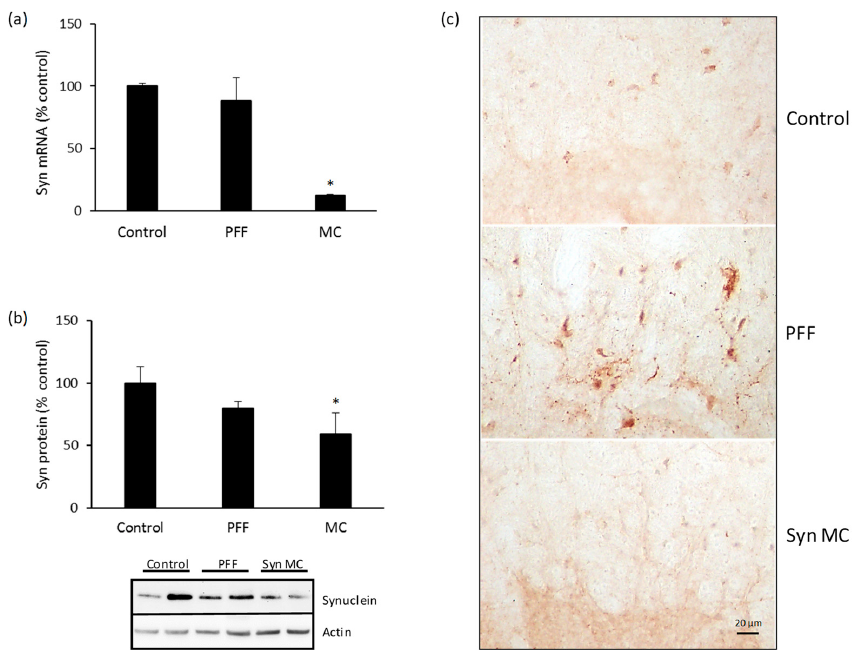
Figure 2. Alpha-synuclein downregulation in spinal cord of mice treated with anti-alpha-synuclein shRNA-MC RVG-EV. Analyses of alpha-synuclein mRNA expression ( a ) and protein levels ( b ) nor- malized to actin. Typical western blot is shown. ( c ) Cord sections were stained for S129 phospho- synuclein, typical immunohistochemical images are shown. Scale bar represents 20 µm. Values are expressed as mean ± SEM ( n = 5). * p < 0.05, non-parametric Kruskal-Wallis test.